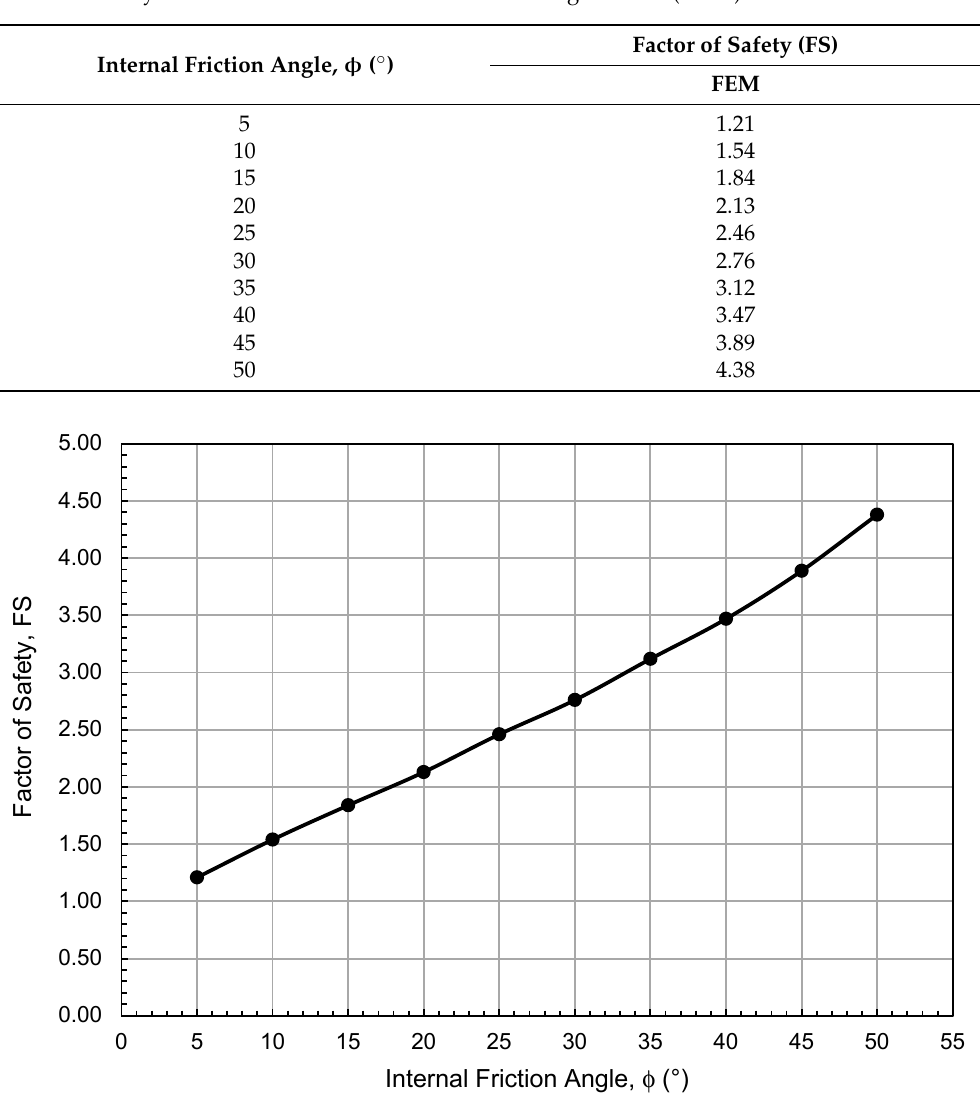
Figure 17. Variation in FS with φ for the reinforced slope.